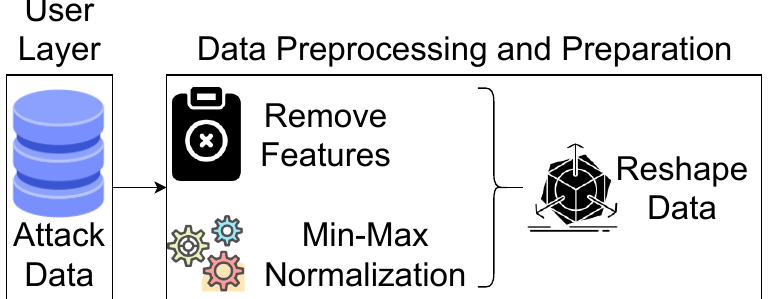
Figure 3. Data preprocessing in the analytic